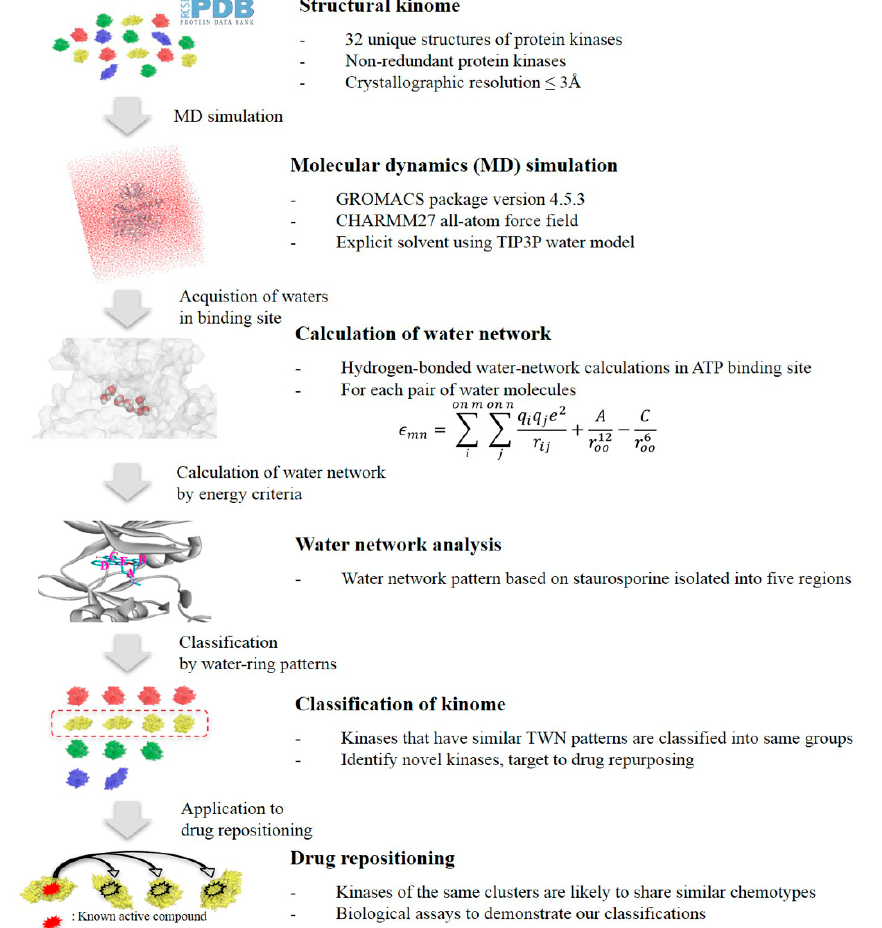
Figure 2. Flow chart describing the drug repositioning approach on the basis of topological water network (TWN) analysis.